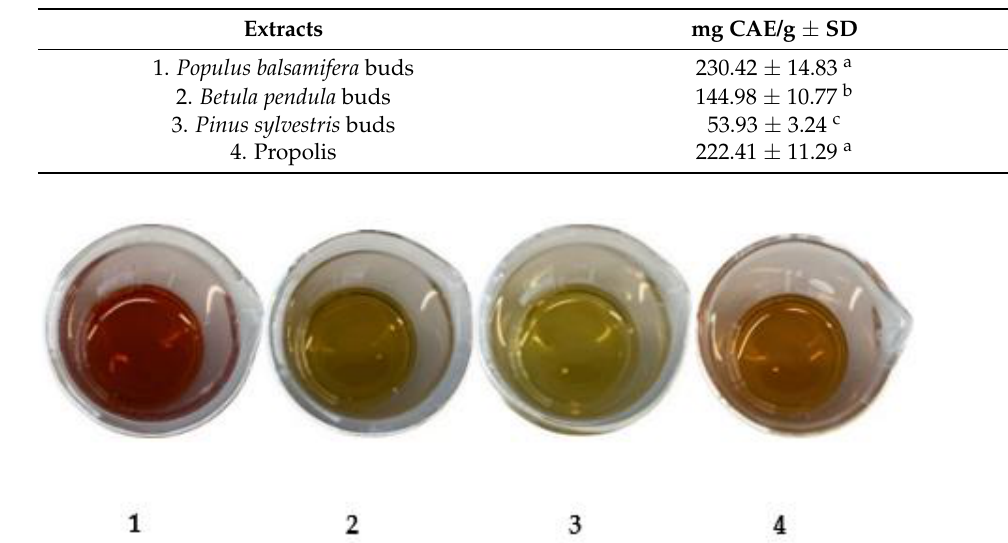
Table 2. HPLC analysis of ethanolic poplar, birch, pine buds and propolis extracts (mg/g). Results expressed as mean and standard deviation (SD) of three measurements.